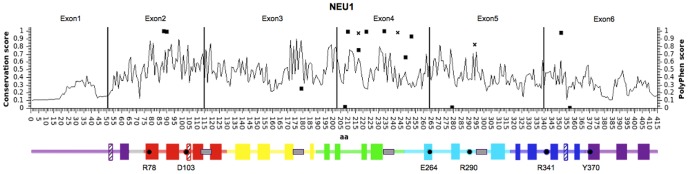
Distribution of variants identified in NEU1.Schematic representation of NEU1 protein, with amino acid position on the X axis. Black vertical lines divide the 6 exons of NEU1 gene. Line graph indicates the conservation score for each amino acid position as calculated by ScoreCons. The identified missense variants are represented as squares, with Y values corresponding to PolyPhen score. The missense variants already identified as pathological alleles in sialidosis are represented as diagonal crosses. Below the graph, schematic representation of NEU1 structural elements: full color blocks represent beta-strand elements, while crossed blocks represent helices. Color code identifies the 6 blades of the β-propeller structure as described in [35]. Gray boxes represent the Asp-box elements and essential catalytic residues are indicated with dots and their residue number. Positions of all elements are relative to the amino acid position in the graph above.